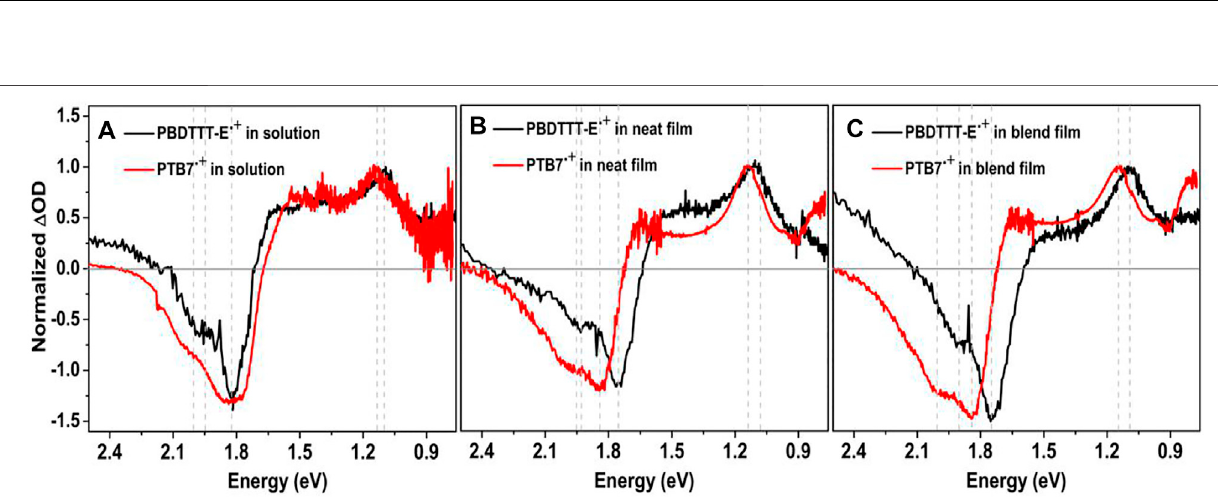
FIGURE 7 | (A) Normalized TA kinetics of the neat PBDTTT-E and PTB7 active layers at 900 and 700 nm and (B) normalized kinetics of the blend PBDTTT-E: PC 71 BM and PTB7:PC 71 BM active layers at 900 nm; the photoexcitation energy and excitation fl uency are 600 nm and 2.18 × 10 13 photons Normalized TA bleaching kinetics (700 nm) of the PBDTTT-E:PC 71 BM (C) and PTB7:PC 71 BM (D) active layer after photoexcitation at 600 nm under the different excitation fl uencies (2.18 × 10 13 and 3.73 × 10 13 photons